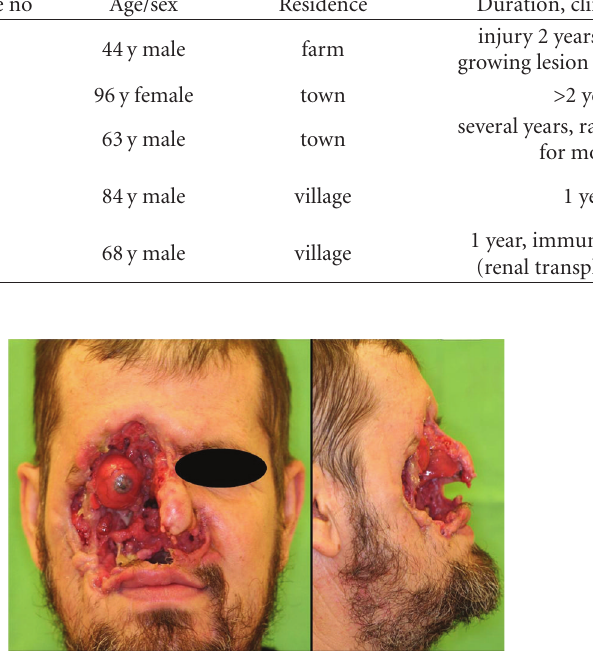
Figure 1: Case 1: A mutilating tumor on the right side of the patient’s face.